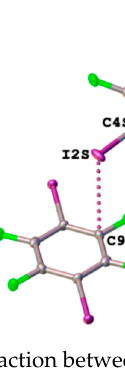
Figure 5. The lp(I) ··· π (C) interaction between 1,4-FIB molecules in ASZ · 1.5( 1,4-FIB ). Figure 5. The lp(I)··· π (C) interaction between 1,4-FIB molecules in ASZ ·1.5( 1,4-FIB ).